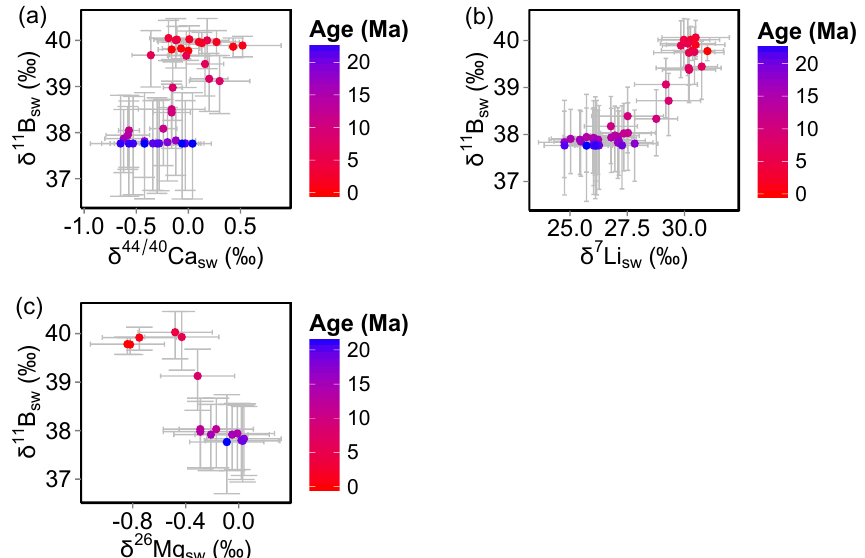
Figure 13. Crossplots of the records of δ 11 B sw using a variable pH gradient derived from δ 13 C (error bars show 2 σ uncertainty), with δ 44 / 40 Ca sw from Griffith et al. (2008) (error bars show 2 σ uncertainty), δ 7 Li sw from Misra and Froelich (2012) (error bars show 2 σ uncertainty) and δ 26 Mg sw from Pogge von Strandmann et al. (2014) (error bars are ± 0.28‰ and include analytical uncertainty and scatter due to the spread in modern O. universa and the offset between the two analysed species). The colour of the data points highlights the age of the data points where red = modern and blue =